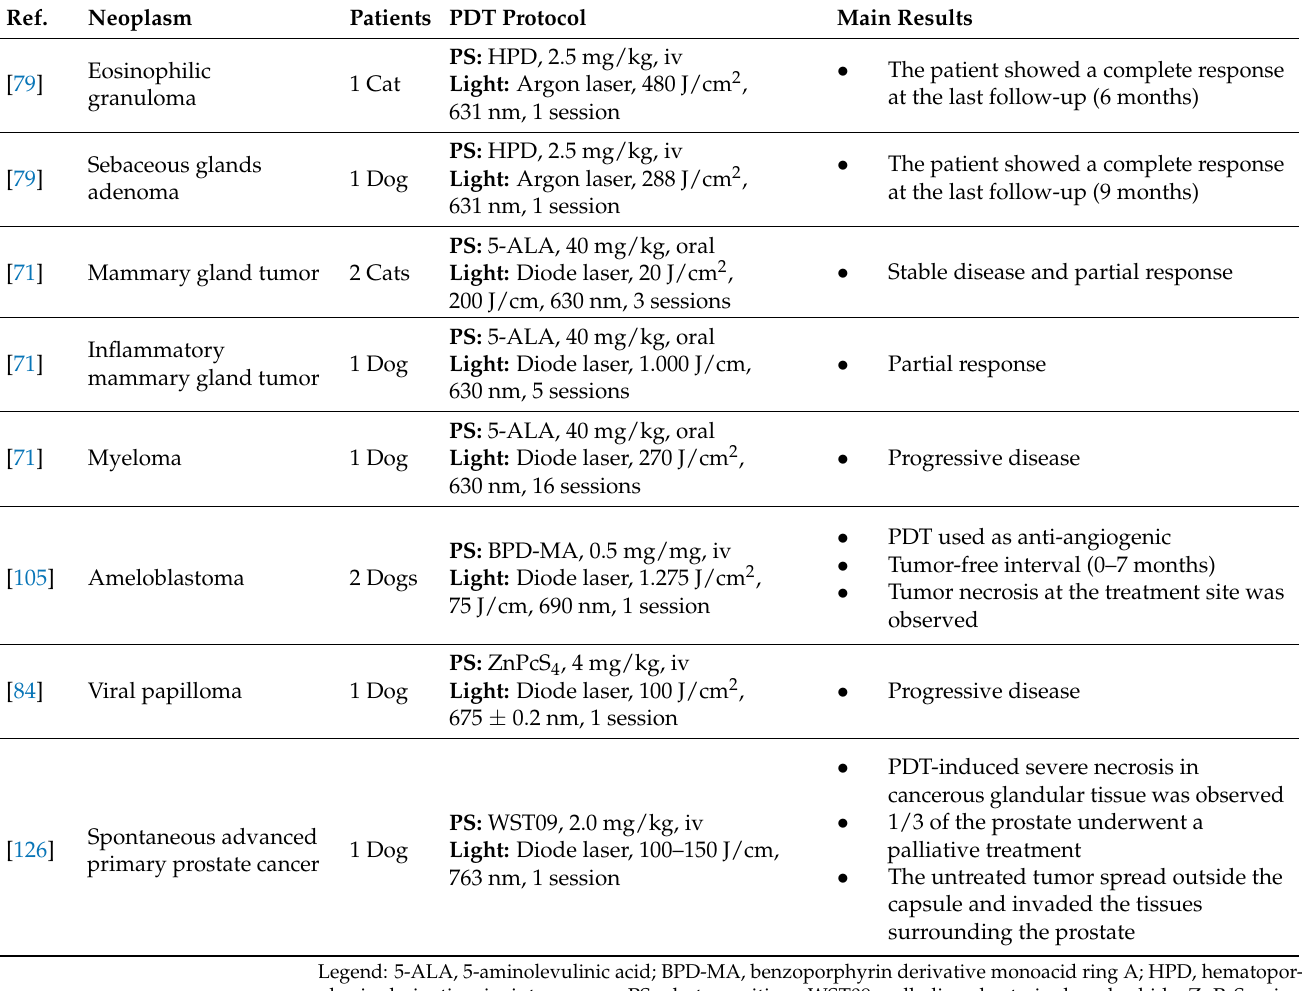
Table 5. Clinical studies on PDT in animals with other